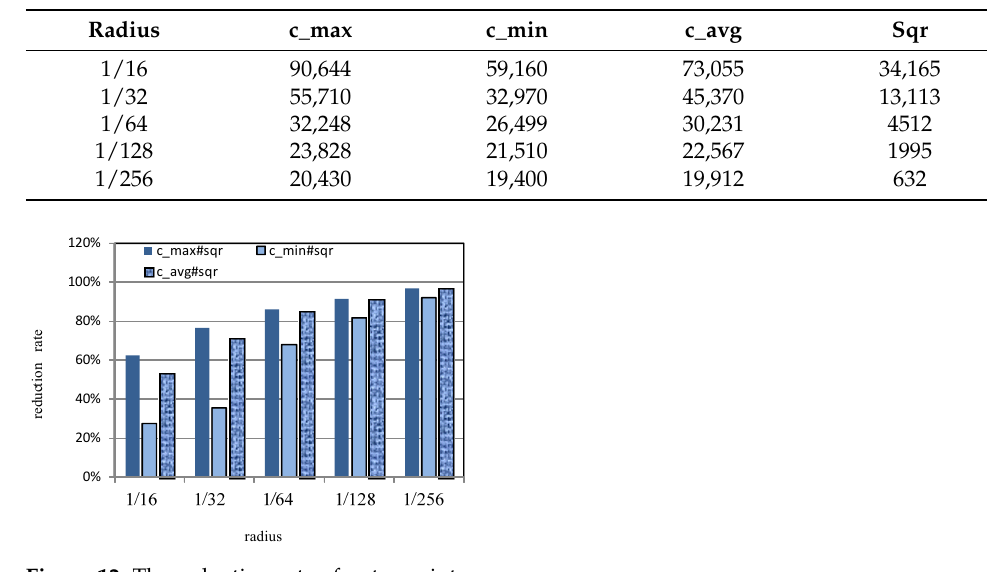
Figure 12. The reduction rate of outer points.